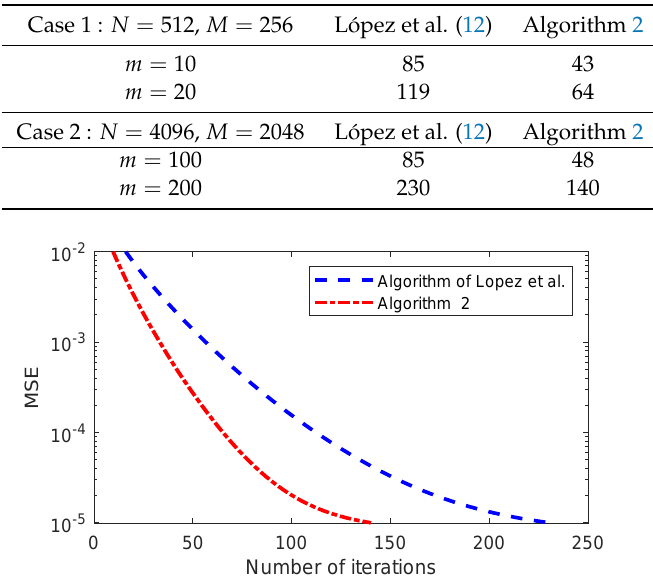
Figure 3. MSE versus number of iterations of Algorithm 2 in case N = 4096, M = 2048 and m = 200.